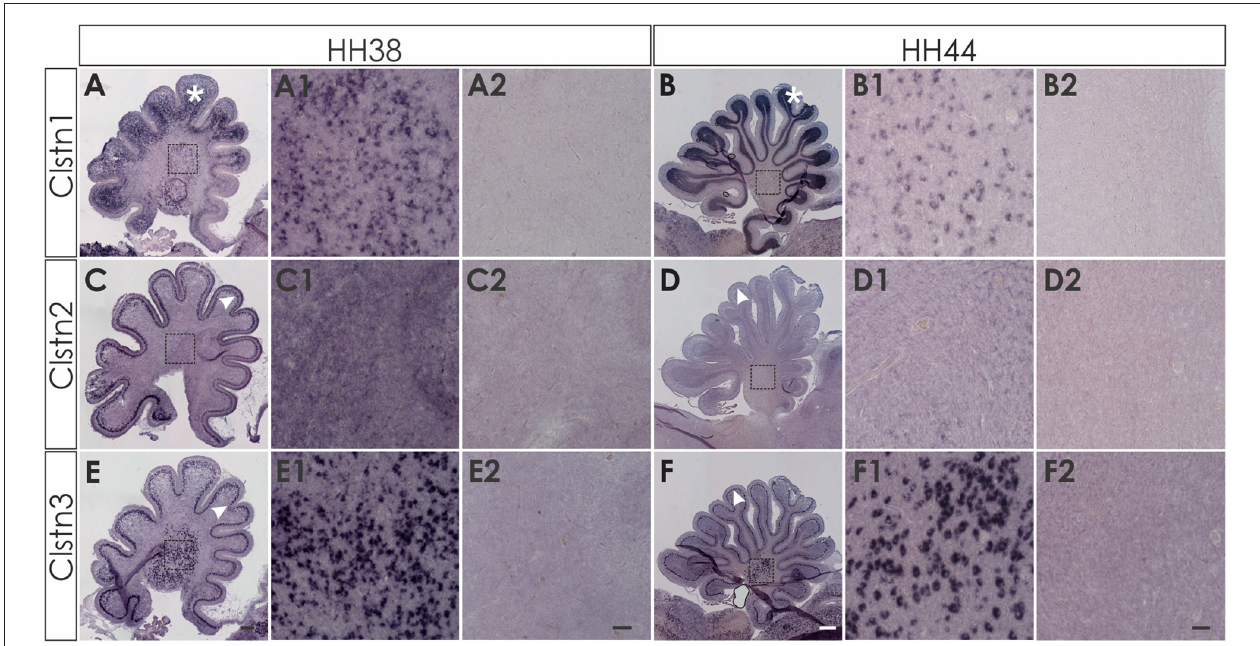
FIGURE 7 | Calsyntenin expression persists throughout cerebellar development. Clstn1 is expressed in the developing inner granule cell layer (IGL; A ; white asterisk) and persists in the DCN at HH38 (A,A1) . This pattern persists to HH44 (B,B1) . Clstn2 is expressed in Purkinje cells (white arrowhead) at HH38 (C) and still at HH44 (D) , although levels are very low by the end of embryonic development (see also Figure 8 ). Clstn2 was never found in DCN (C1,D1) . Clstn3 expression was found in Purkinje cells at HH38 (E) and at HH44 (F) , as well as in DCN (E1,F1) . Sections shown in (A2–F2) are equivalent to (A1–F1) but were processed with the respective sense probes. (A1–F2) represent high-magnification views of the area outlined in (A–F) . Bar: (A,C,E) 200 µ m; (B,D,F) 500 µ m; (A1–F2) 50 µ m.